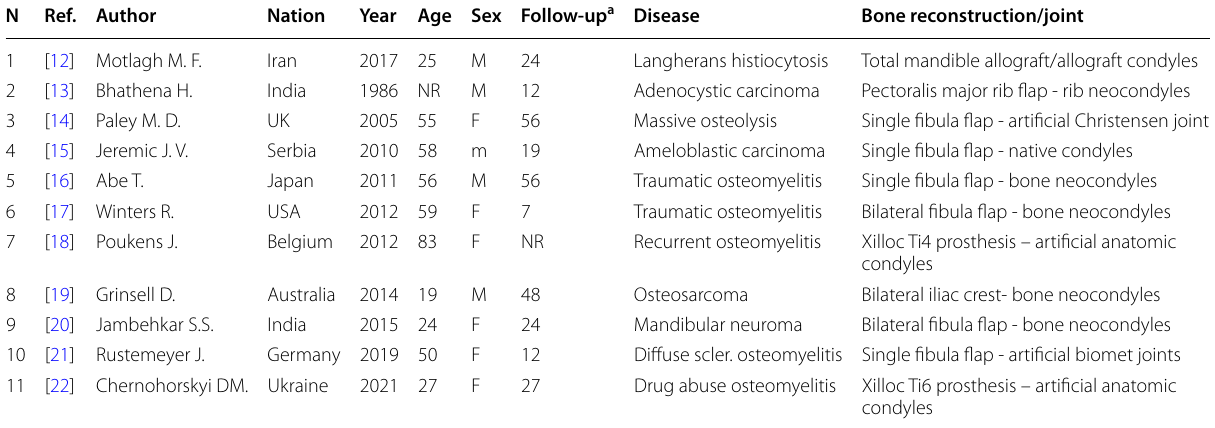
Table 1 Summary table of the scientific papers reporting a “bicondylar mandibular reconstruction” — PubMed Library search results, selected and checked by a Google cross-search matching from 1980 to date (see references list from 12 to